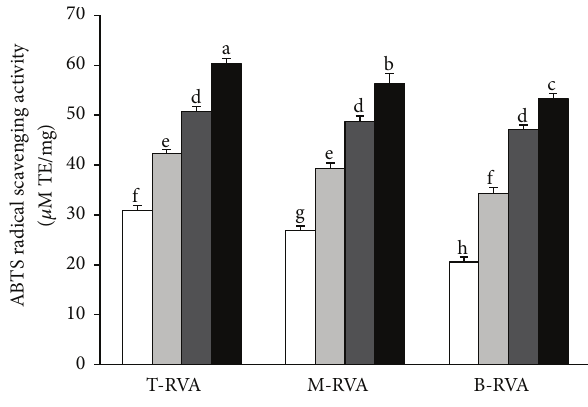
Figure 4: The effect of RVA on ABYS radical scavenging activity. a – g Values not sharing a common letter are significantly different at 𝑃 < 0.05 by Dunnett’s multiple range tests. Light gray square, 125 𝜇 g/mL; gray square, 250 𝜇 g/mL; dark grey square, 500 𝜇 g/mL; black square, 1,000 𝜇 g/mL.